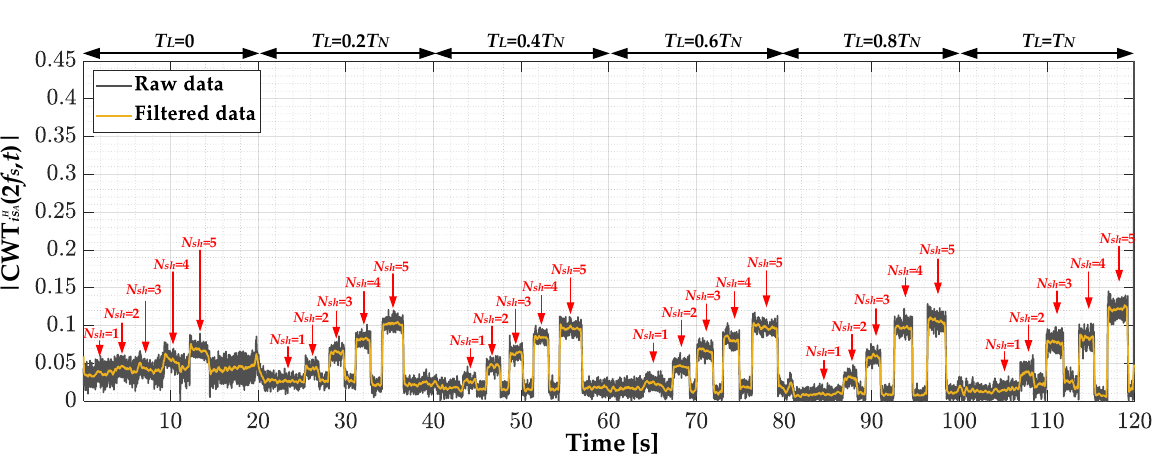
Figure 8. ( a ) CWT scalogram of the stator phase current envelope waveform; ( b ) 2D and ( c ) 3D scalograms of the stator phase current envelope waveform for narrowed frequency range ( T L = var, f s = 100 Hz). Figure 9 shows the raw and filtered waveforms of |CWT isH A (2 f s , t )|. The increases in its value caused by the ITSC are very similar to those for the 3 f s component for the stator phase current. Nevertheless, for the unloaded motor ( T L = 0), the increase is less notable.